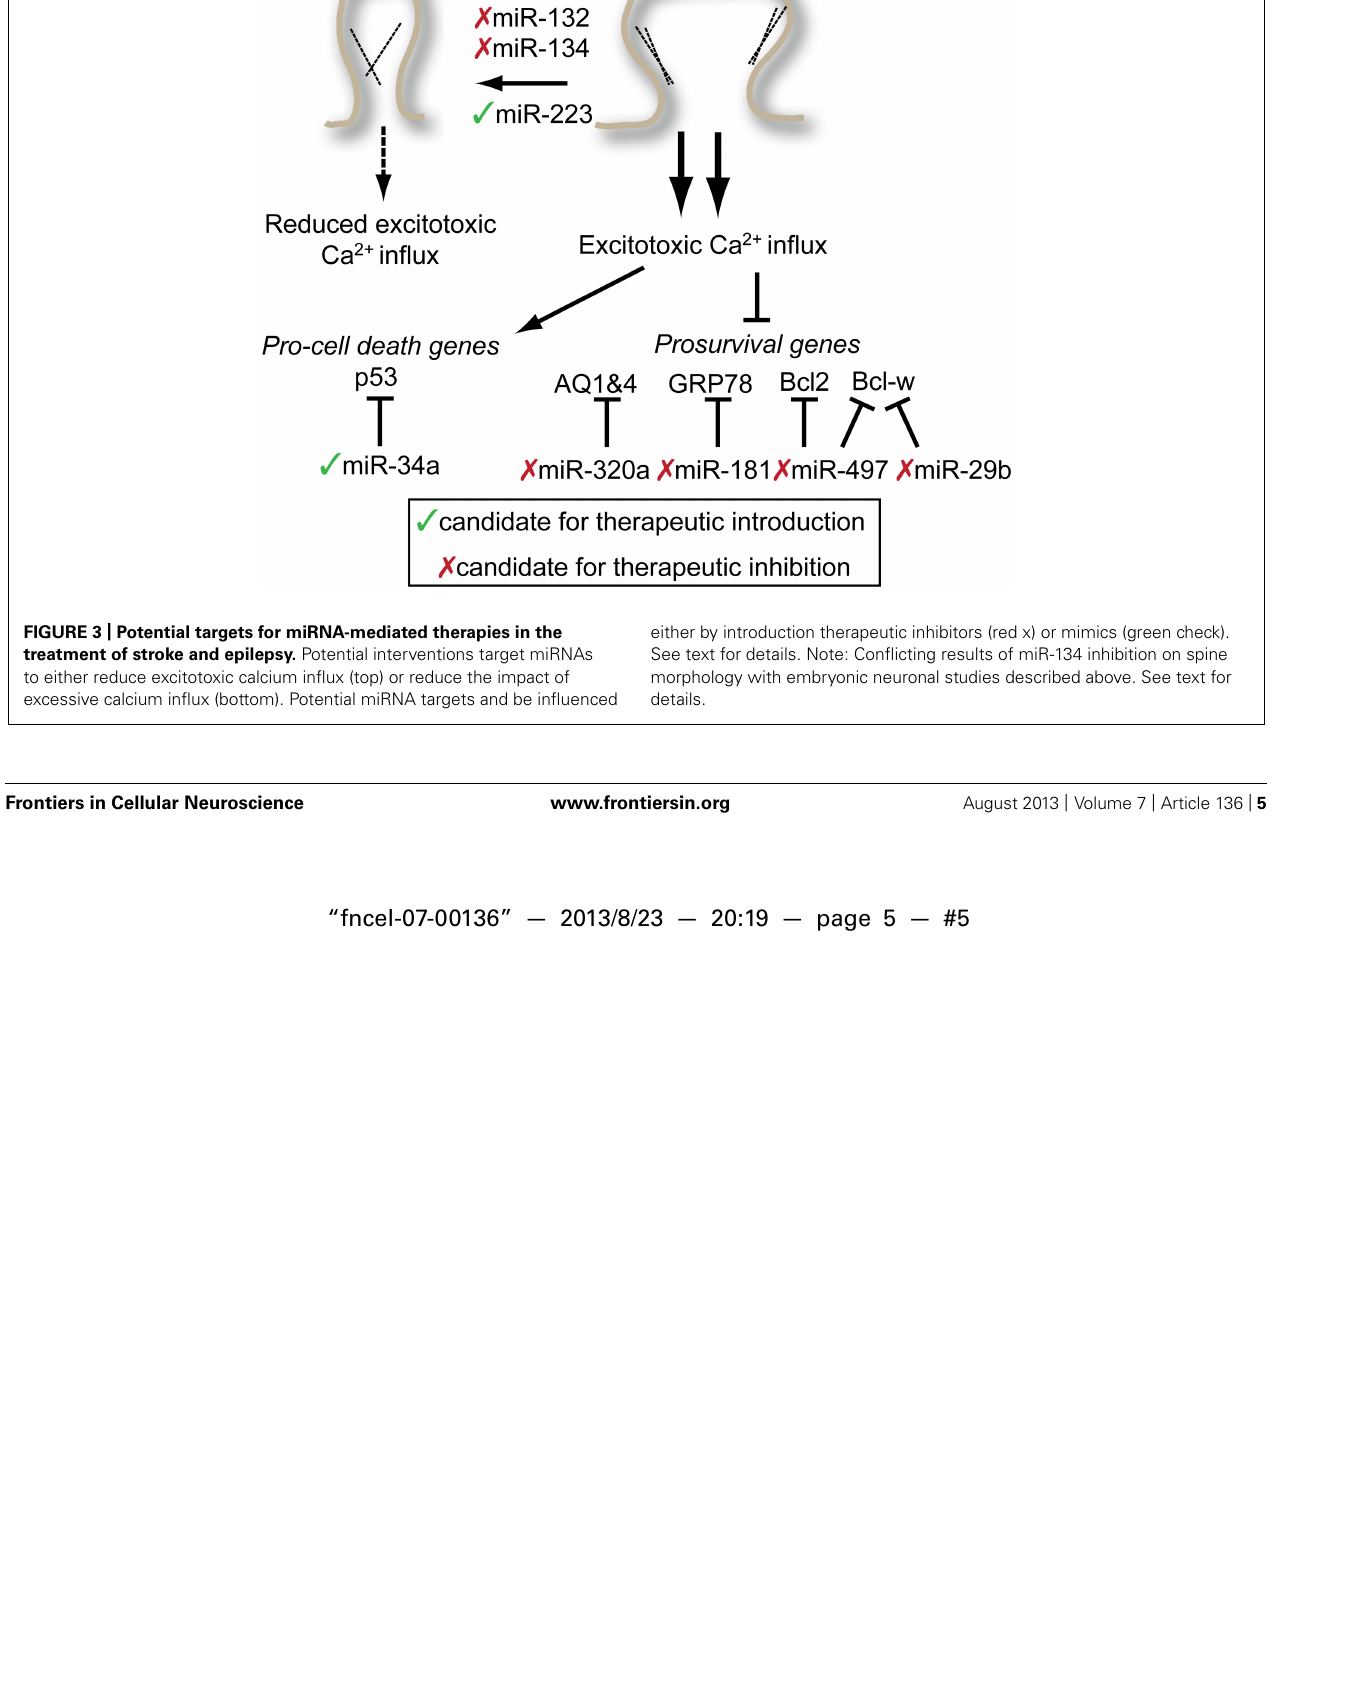
either by introduction therapeutic inhibitors (red x) or mimics (green check). See text for details. Note: Conflicting results of miR-134 inhibition on spine morphology with embryonic neuronal studies described above. See text for